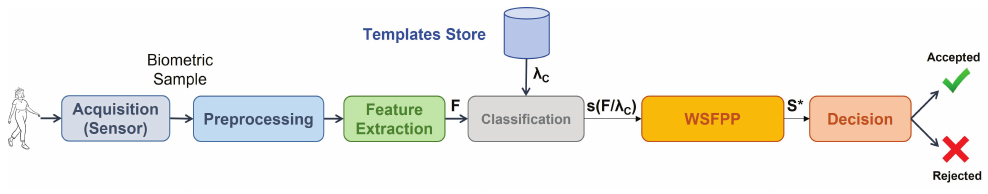
Figure 2. Proposal of system with Window Score Fusion Post-Processing (WSFPP)